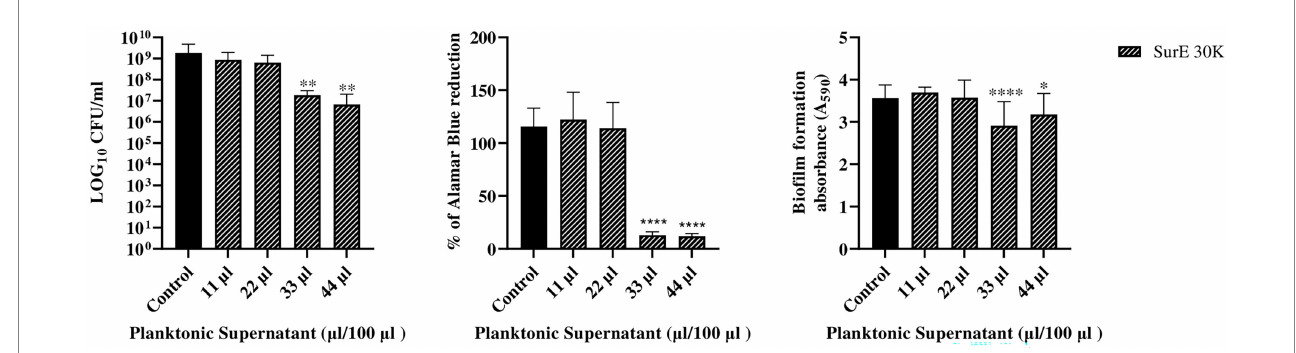
FIGURE 3 Determination of MBEC of SurE 30 K through CFU counts, metabolic assay, and CV assay vs. P. aeruginosa ATCC 27853. Data are presented as the mean of three replicates from two independent experiments. The statistical comparison between the control and treated samples was determined with a one-way ANOVA. The control was made up of media with the supplement of MRS broth. The error bars represent the standard deviation. The asterisks stand for p -value: * p < 0.05, ** p < 0.01, and **** p < 0.0001.